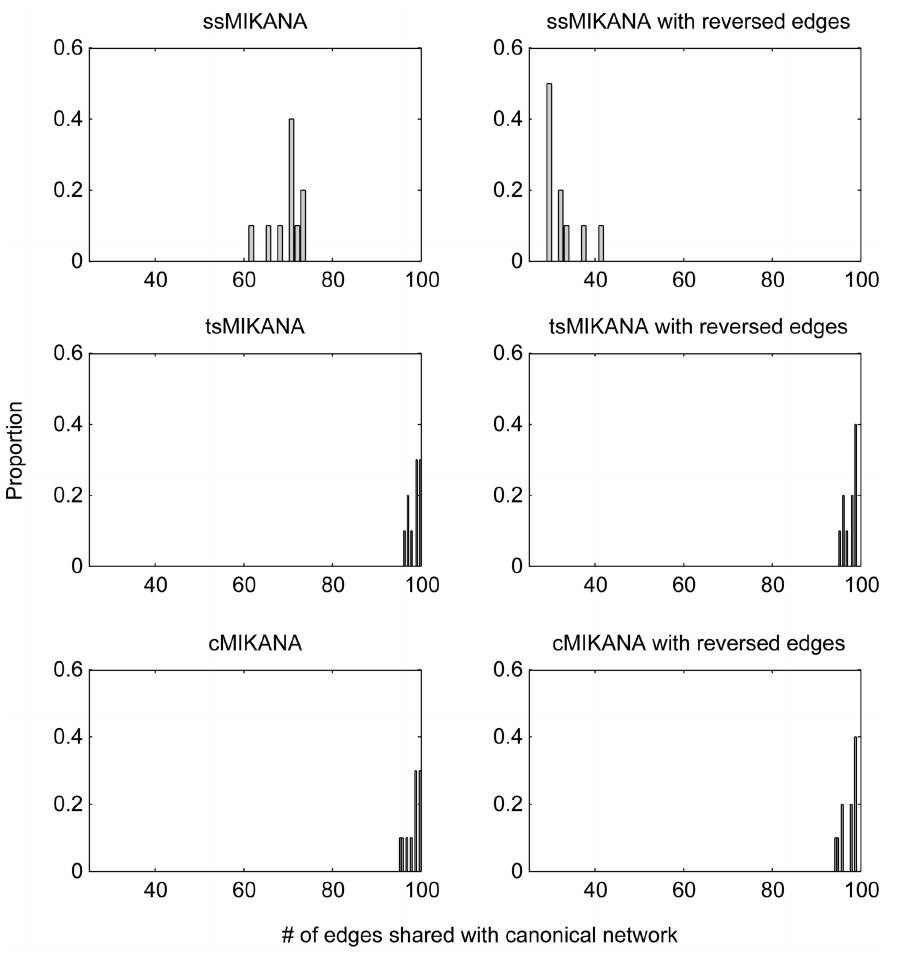
Figure 3. Comparison of the directionality of edges in the ssMIKANA, tsMIKANA and cMIKANA network models. Scale-free networks with 100 genes were generated and related steady-state datasets were simulated. Time-series data were collected at each time point in 10 replicates. 10% noise were added to data. The proportion of edges in the canonical networks found in the forward network models (left column) and in the reversed network models (right column) were computed.